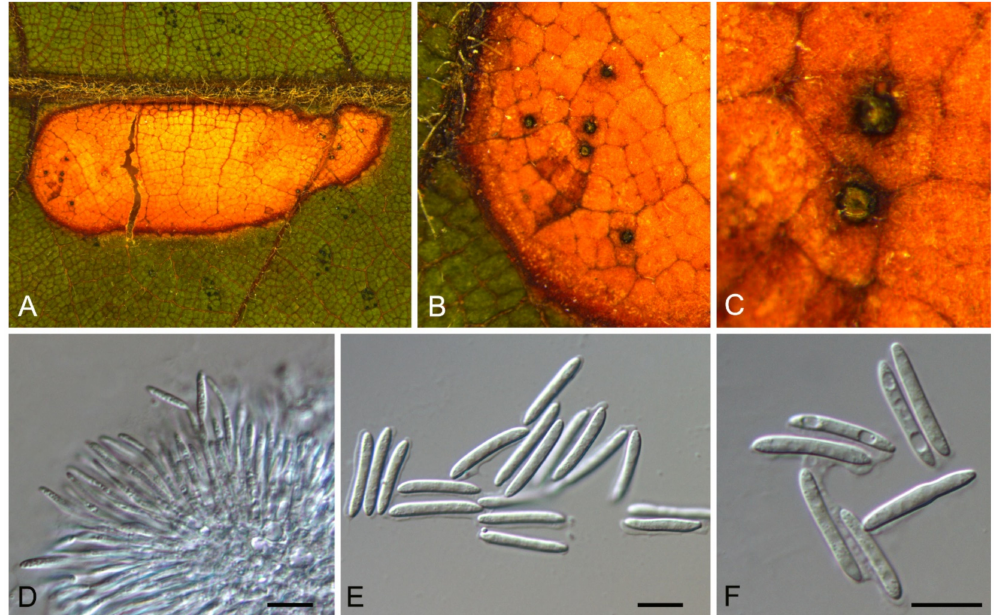
Figure 26. Coniella castaneicola (BJFC-S1793). ( A – C ) Conidiomata on the diseased leaves of Castanea mollissima ; ( D ) Conidio- genous cells giving rise to conidia; ( E , F ) Conidia. Scale bars: ( D – F ) = 10 µ